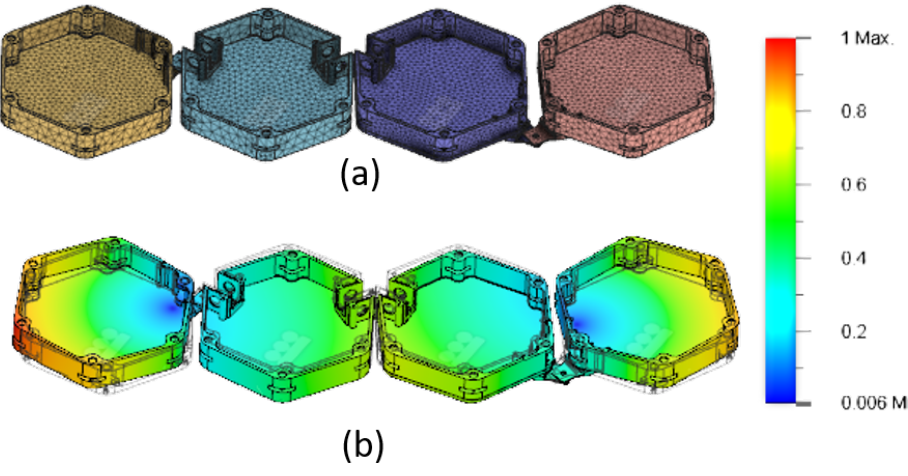
Figure 7. ( a ) Meshed model of the platform. ( b ) The fourth mode shape of the robot